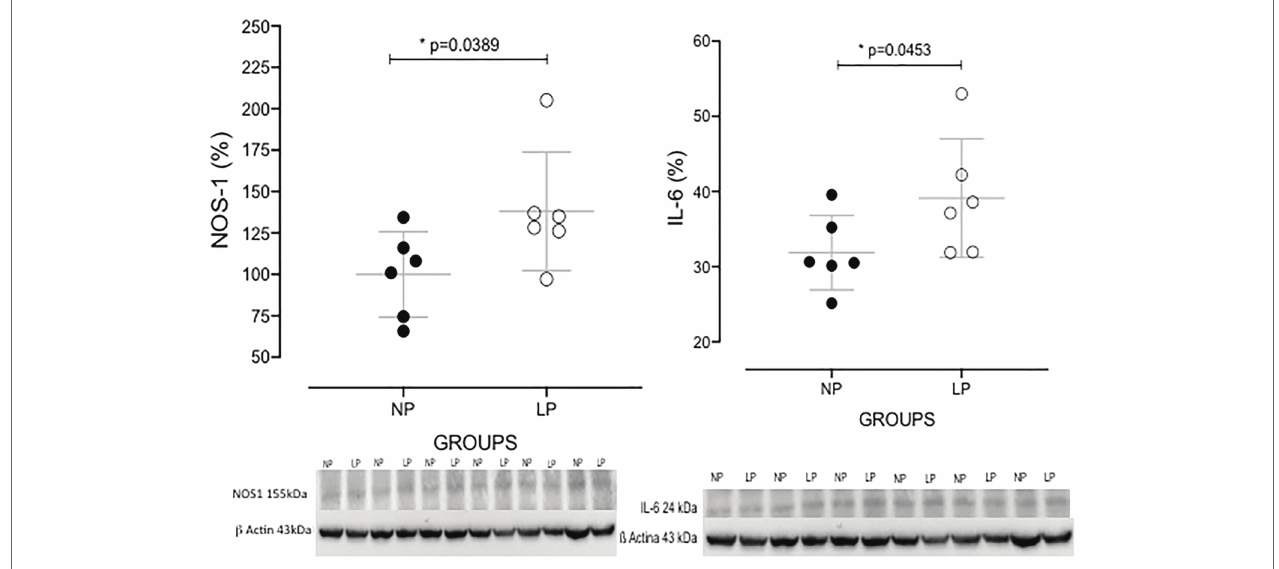
FIGURE 11 | Western blot analyses of NOS1 and IL-6 protein expression in the whole kidneys of 24-week-old NP ( n = 5) and LP ( n = 5) offspring. Data are presented as scatter dot plots; unpaired Welch’s t -test was used for data analysis. The level of significance was set at p <